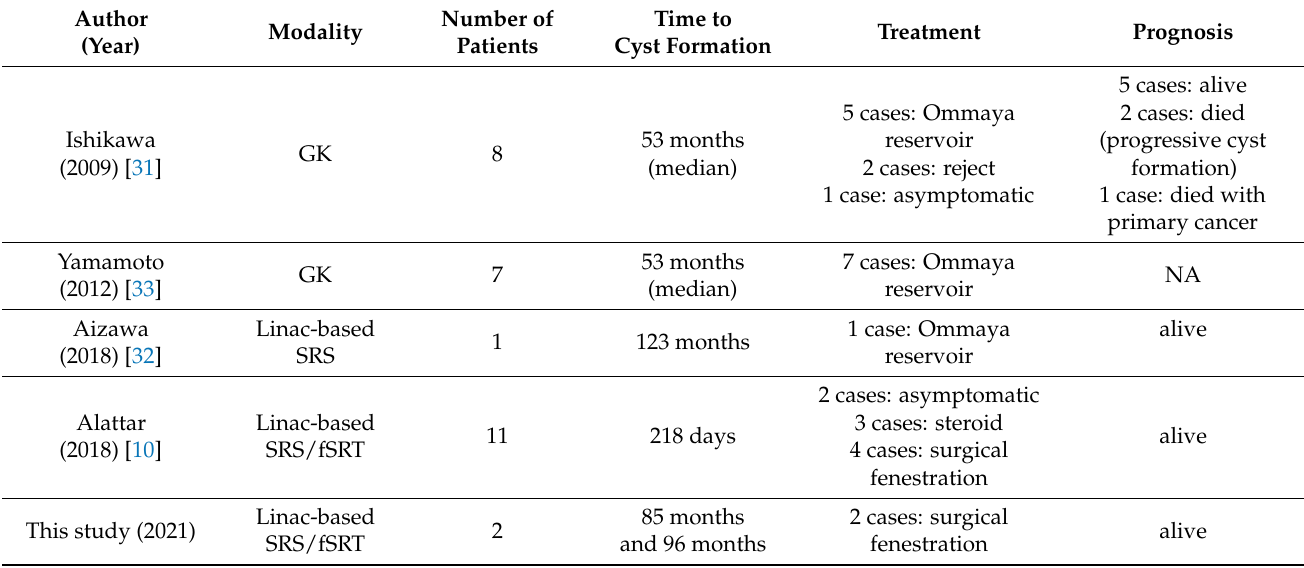
Table 4. Summary of cyst formation after